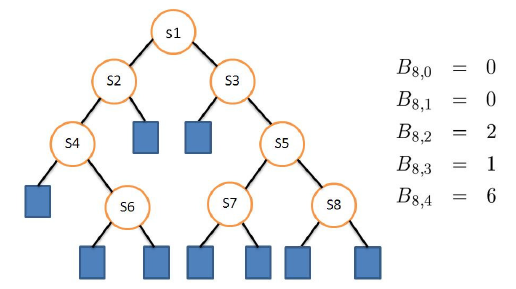
Fig. 1: A digital search tree built on eight strings s 1 , ..., s 8 (i.e., s 1 = 0 ... , s 2 = 1 ... , s 3 = 01 ... , s 4 = 11 ... , etc.) with internal (ovals) and external (squares) nodes, and its